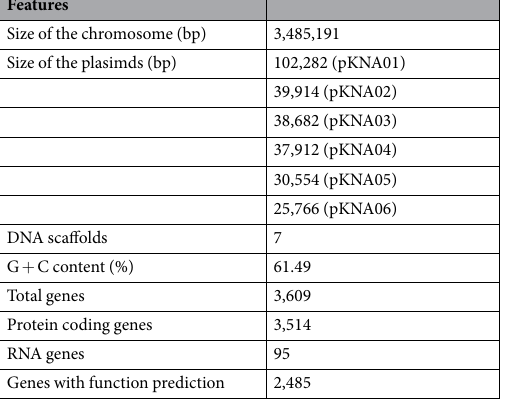
Table 1. General features of the Komagataeibacter nataicola RZS01